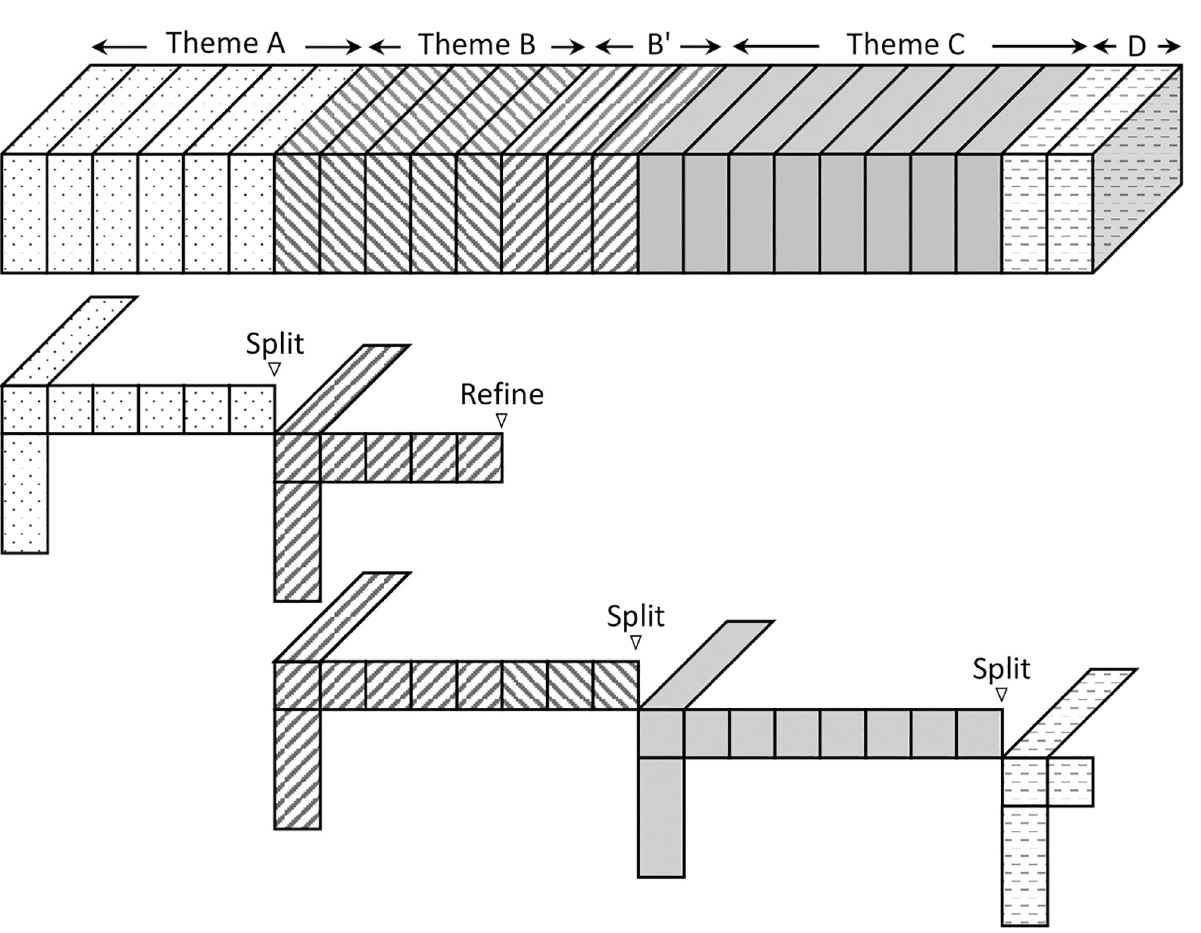
Fig 3. Visualization of split and refinement processes of DAO-CP. When the z-score exceeds the split threshold L (e.g., change from theme A to B ), s DAO-CP re-initializes the new tensor slice using the static CP decomposition. When the z-score is between L r and L s (e.g, change from theme B to B 0 ), the refinement process determines how much information from the previous factors should be retained. Consequently, DAO-CP provides both fast and accurate decomposition for tensor streams even with inconsistent temporal patterns. https://doi.org/10.1371/journal.pone.0267091.g003 Algorithm 2 : Data-Adaptive Online CP Decomposition (DAO-CP)